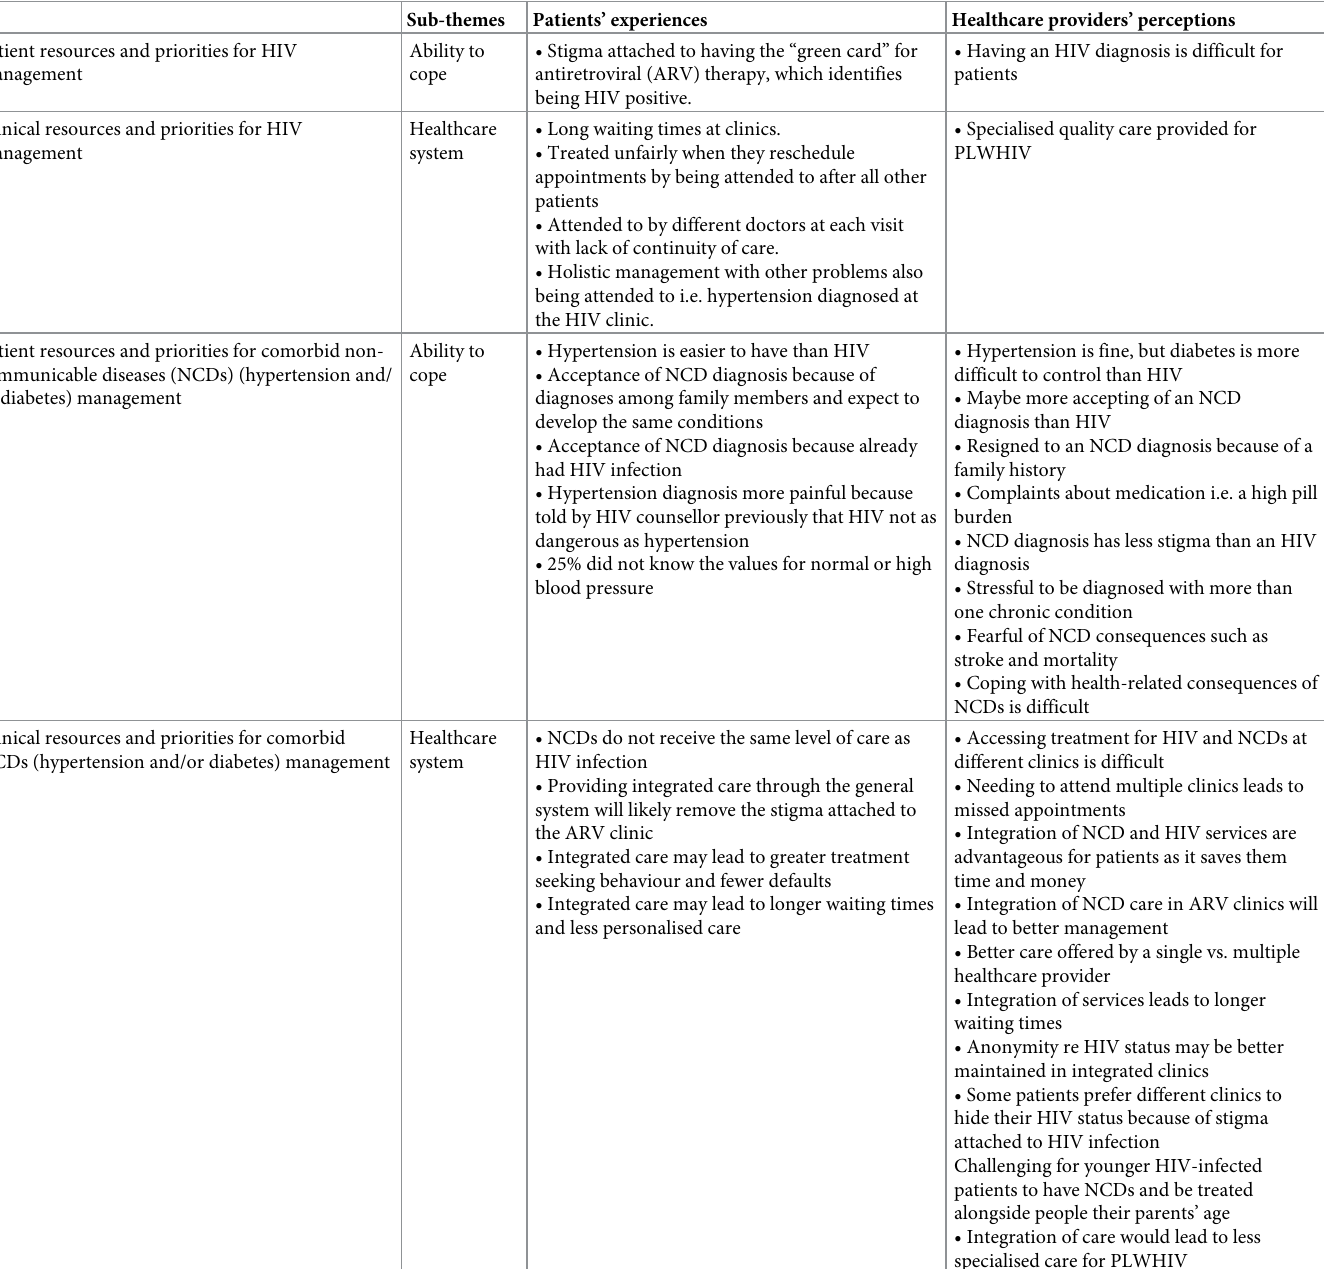
Table 1. Using a framework for understanding care within the context of comorbid chronic conditions to explore the experiences of people living with HIV (PLWHIV) infection and hypertension, and their healthcare providers